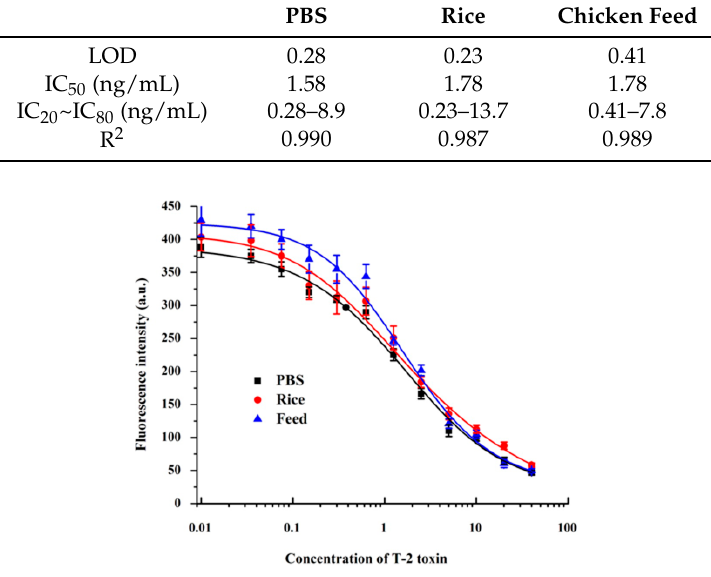
Figure 4. Calibration curves for T-2 in PBS, rice and chicken feed by the FMs-LFIA.